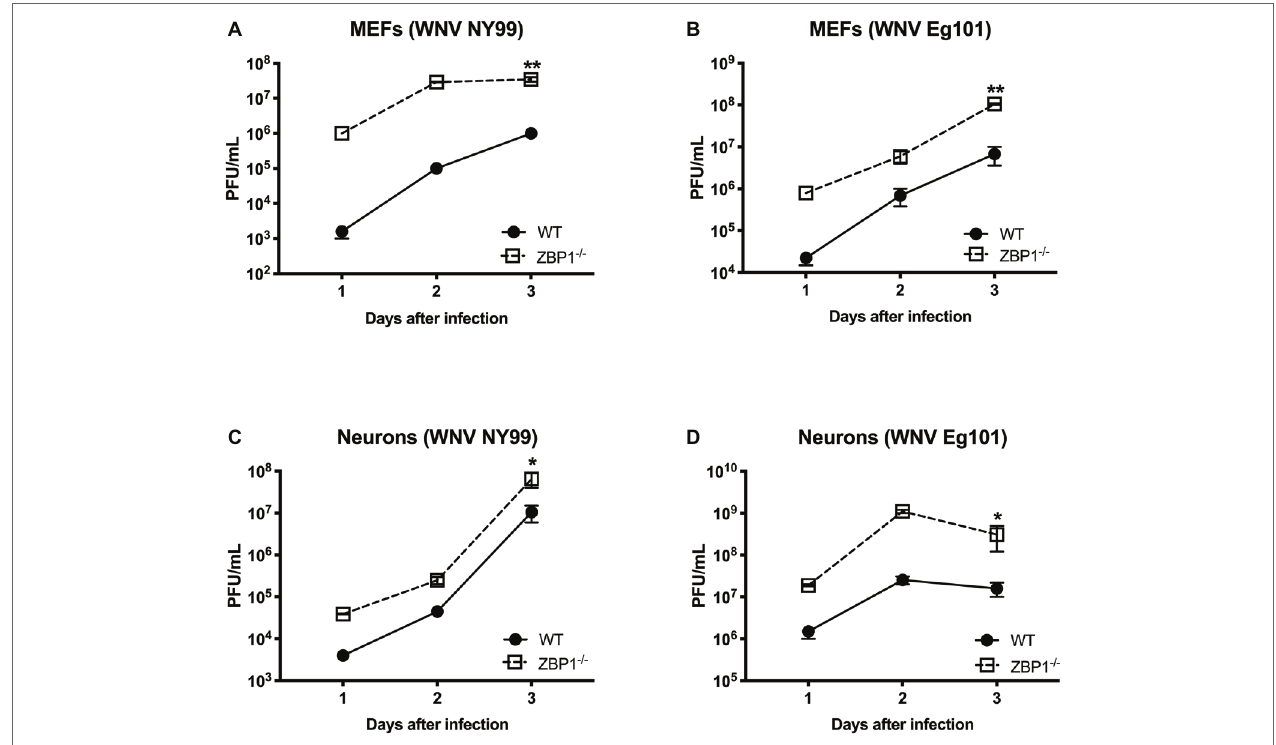
FIGURE 5 | Analysis of virus titers produced by primary cells isolated from WT and ZBP1 −/− mice. (A–D) MEFs and neuronal cultures were infected with WNV NY99 or WNV Eg101 (as described in Materials and Methods) and virus titers in the cell culture supernatants were measured by plaque assay. Results are expressed as PFU/ml ± SEM from at least three independent experiments conducted in duplicate. * p < 0.05, ** p <